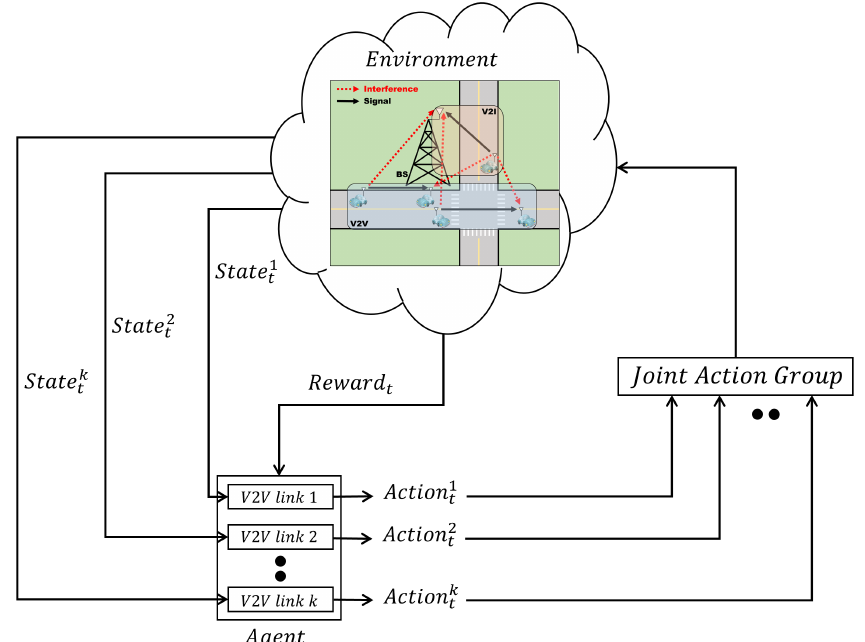
Figure 2. The structure of the RL for the vehicular